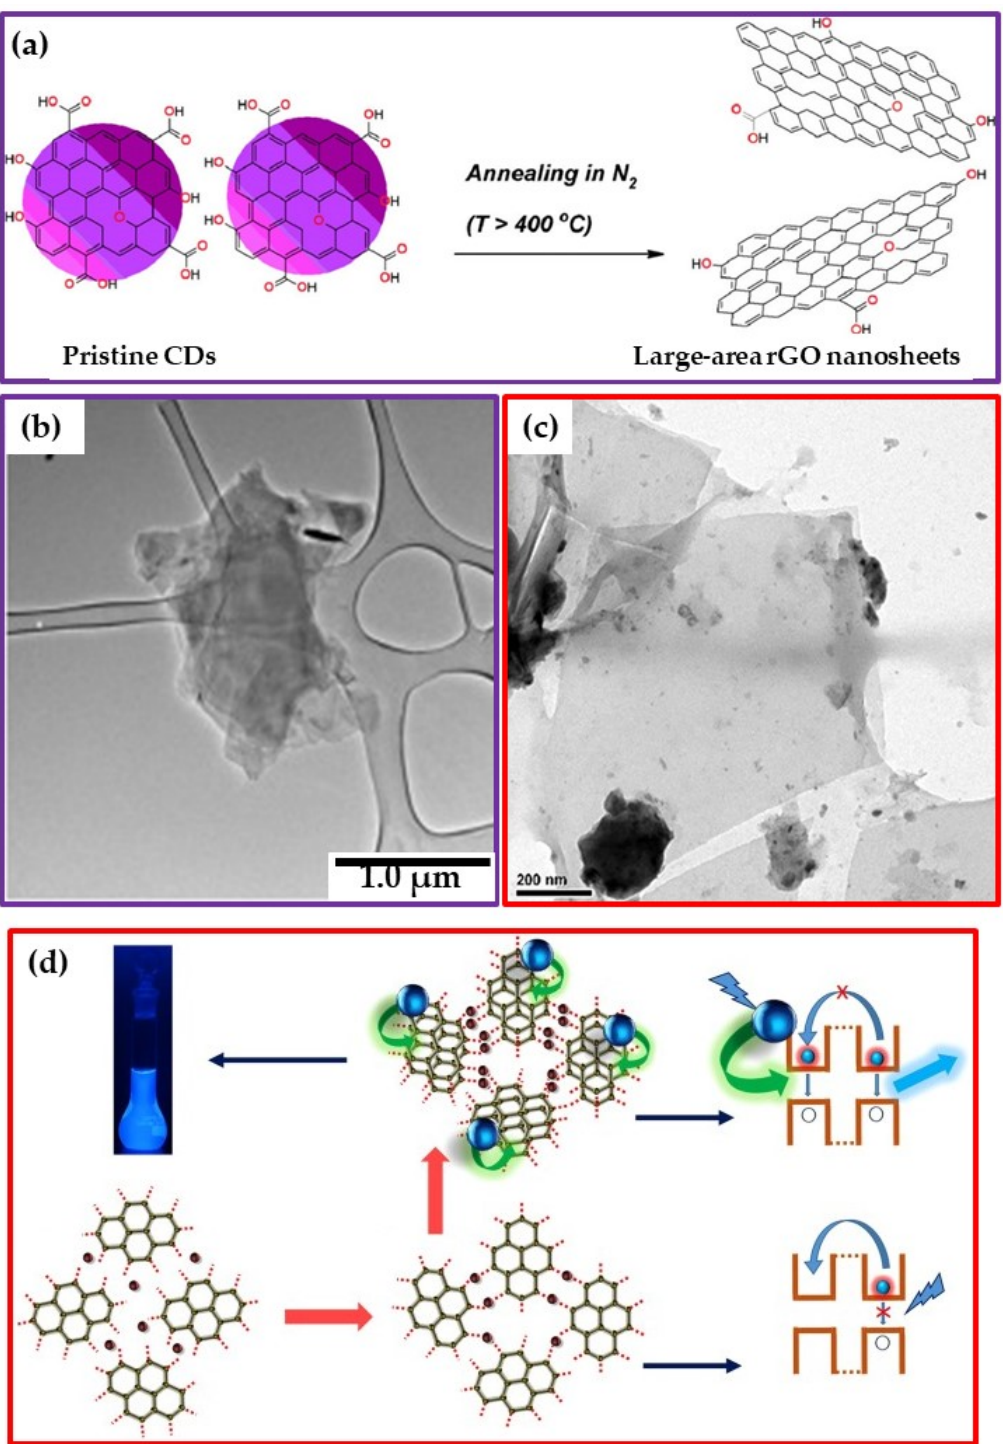
Figure 4. Schematic representation of the synthesis procedure and TEM images of the resulting product formed during the conversion of 0-D CDs to 2-D graphene-like nanosheets using a ( a , b ) high-temperature (> 300 °C) treatment without a catalyst (reproduced with permission from [117] , copyright 2021, Elsevier BV) and ( c , d ) lower-temperature (180 °C) treatment in the presence of a metal catalyst (reproduced with permission from [118] , copyright 2017, Springer Nature).